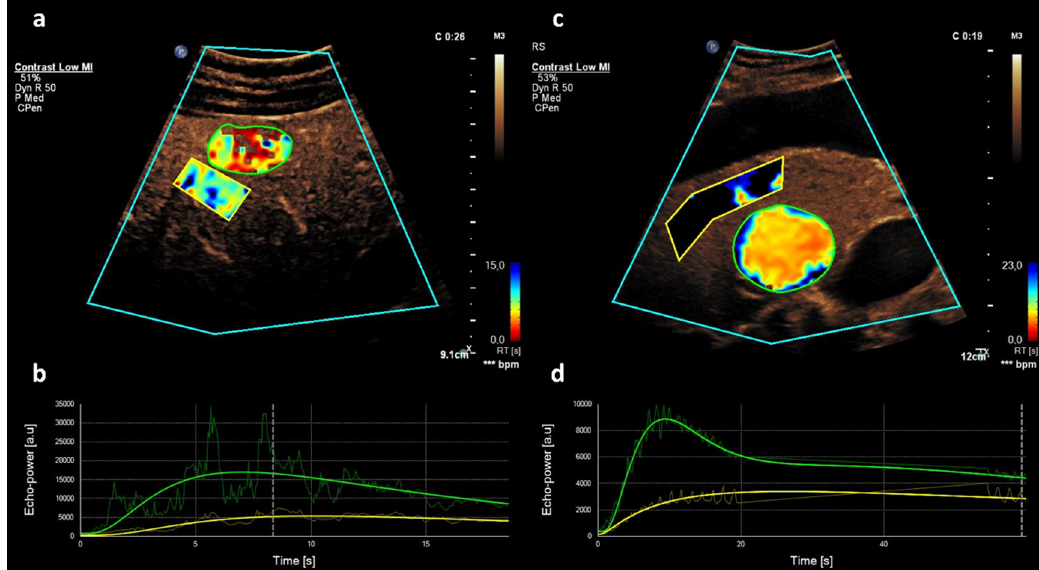
Figure 2. Rise time (RT) in hemangioma and hepatocellular carcinoma. CEUS of the liver with color maps, from red (fast enhancement) to blue (slow enhancement) ( a , c ) and signal intensity curves ( b , d ) during the arterial phase in a 59-year-old male patient with liver hemangioma and steatosis hepatis ( a ) in comparison to a 67-year-old male patient suffering from hepatocellular carcinoma and liver cirrhosis ( c ). The RT of contrast enhancement until the peak enhancement (green curves) differs significantly between the two different target lesions (green) and the surrounding normal liver tissue (yellow). While in hemangioma the curve rises and flattens slowly ( b ), in HCC the RT is much shorter.